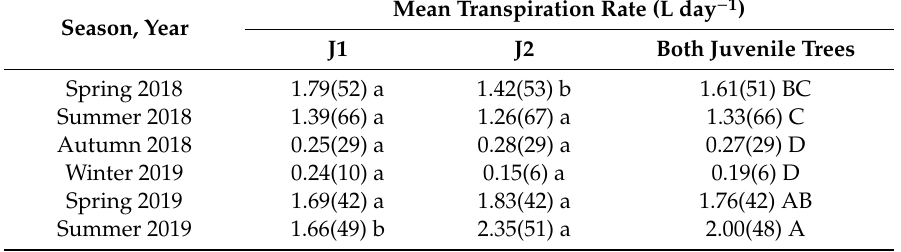
Table 4. Transpiration rates of juniper juvenile trees in the untreated Jensen WS, averaged by individual tree (J1 and J2), and by both juvenile trees, for summer (1 July to 30 September), autumn (1 October to 31 December), winter (1 January to 31 March), and spring (1 April to 30 June), from April 2018 through September 2019. Di ff erent lowercase letters (a, b) along rows indicate significant di ff erences ( p ≤